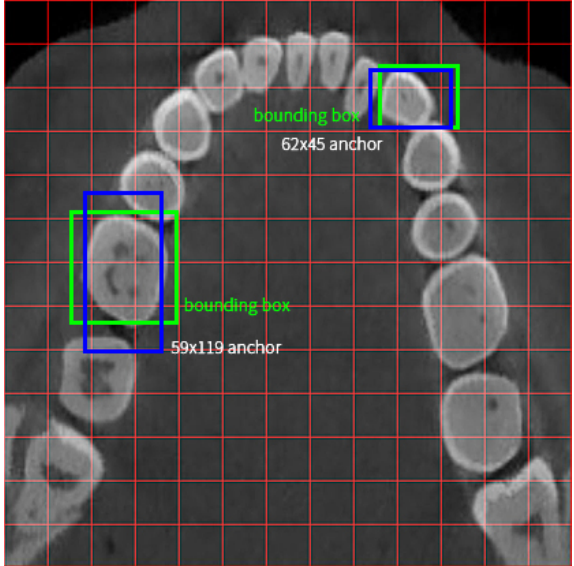
Figure 4. A comparison between tooth detection box and middle-size anchor box. In a main area, each red grid shapes 32 × 32 voxels, and there are a total of 13 × 13 grids. The blue rectangles are default anchors on image after 16 × down sample. The green rectangles are middle-sized ground truth boxes. They are generated by the blue anchors on 16 × down sample feature map